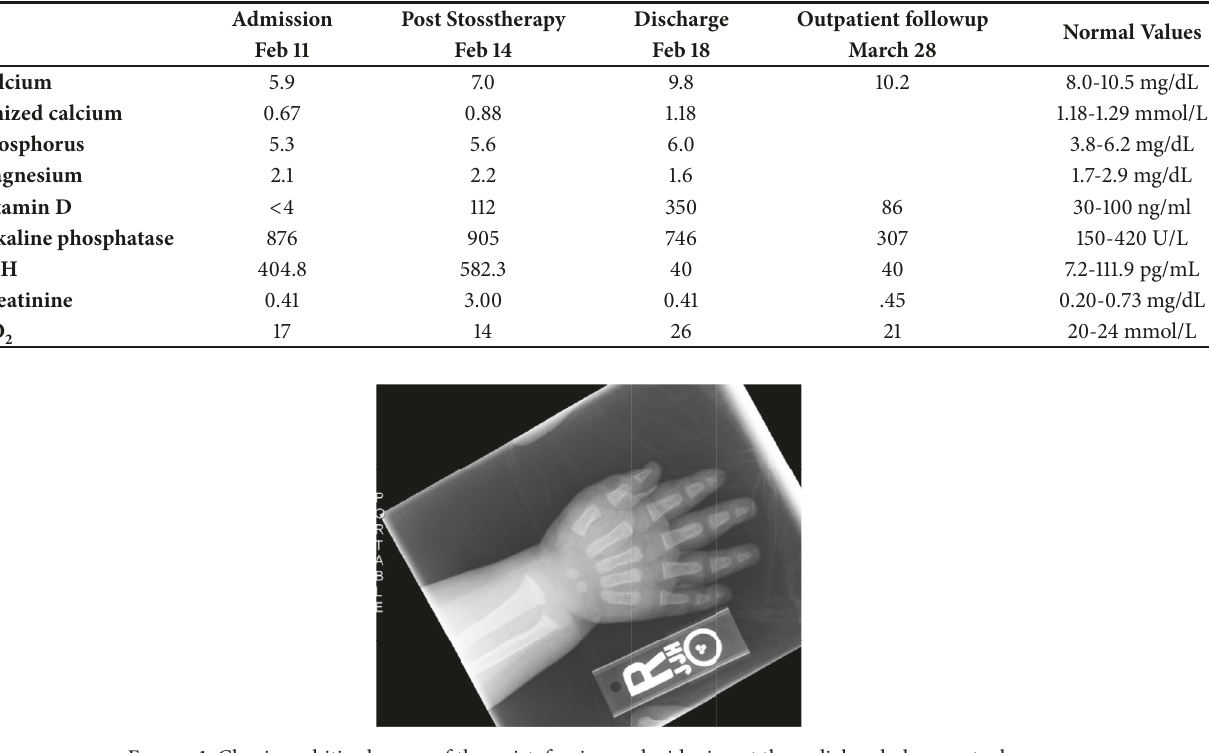
Figure 1: Classic rachitic changes of the wrist: fraying and widening at the radial and ulnar